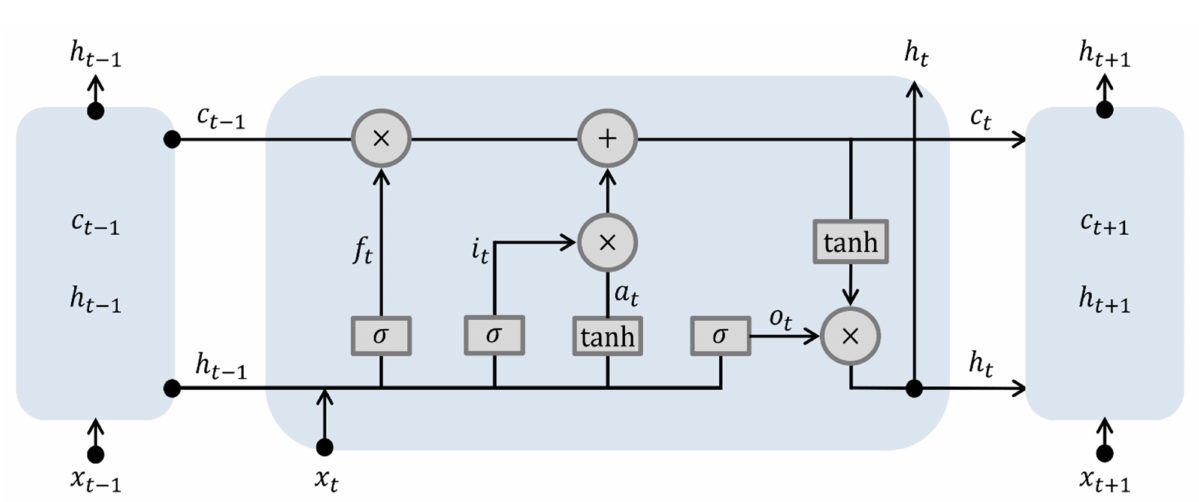
Figure 5. Schematic architecture of the LSTM.